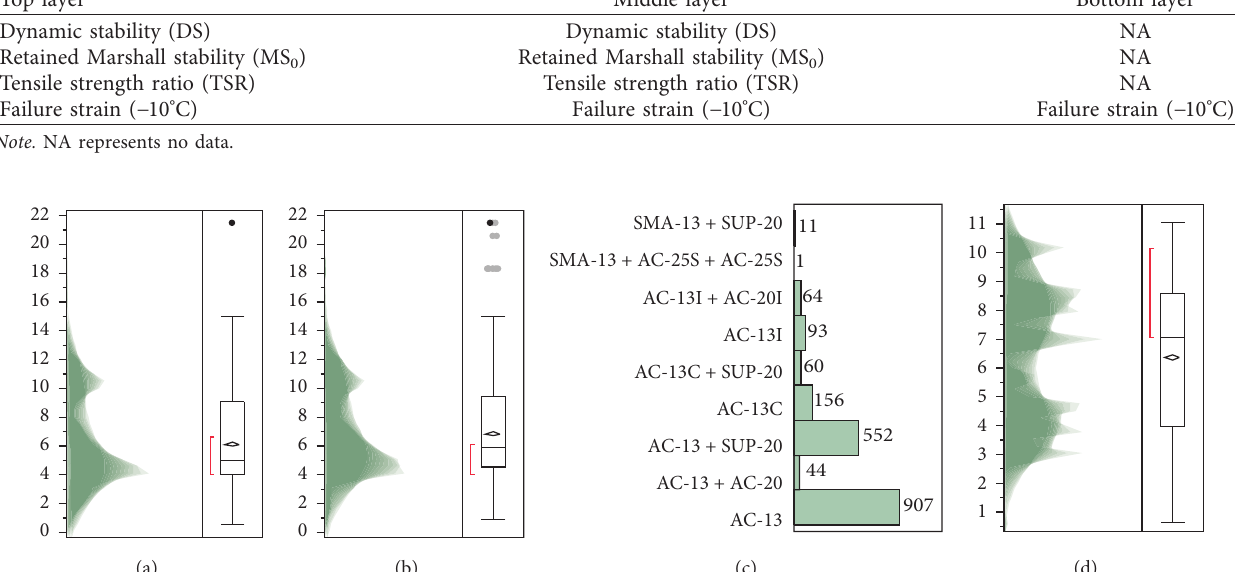
Figure 2: The distribution diagrams of M&R information of all the M&R projects. (a) Milling depth (cm). (b) Resurfacing thickness (cm). (c) Resurfacing material. (d) M&R application time (year).